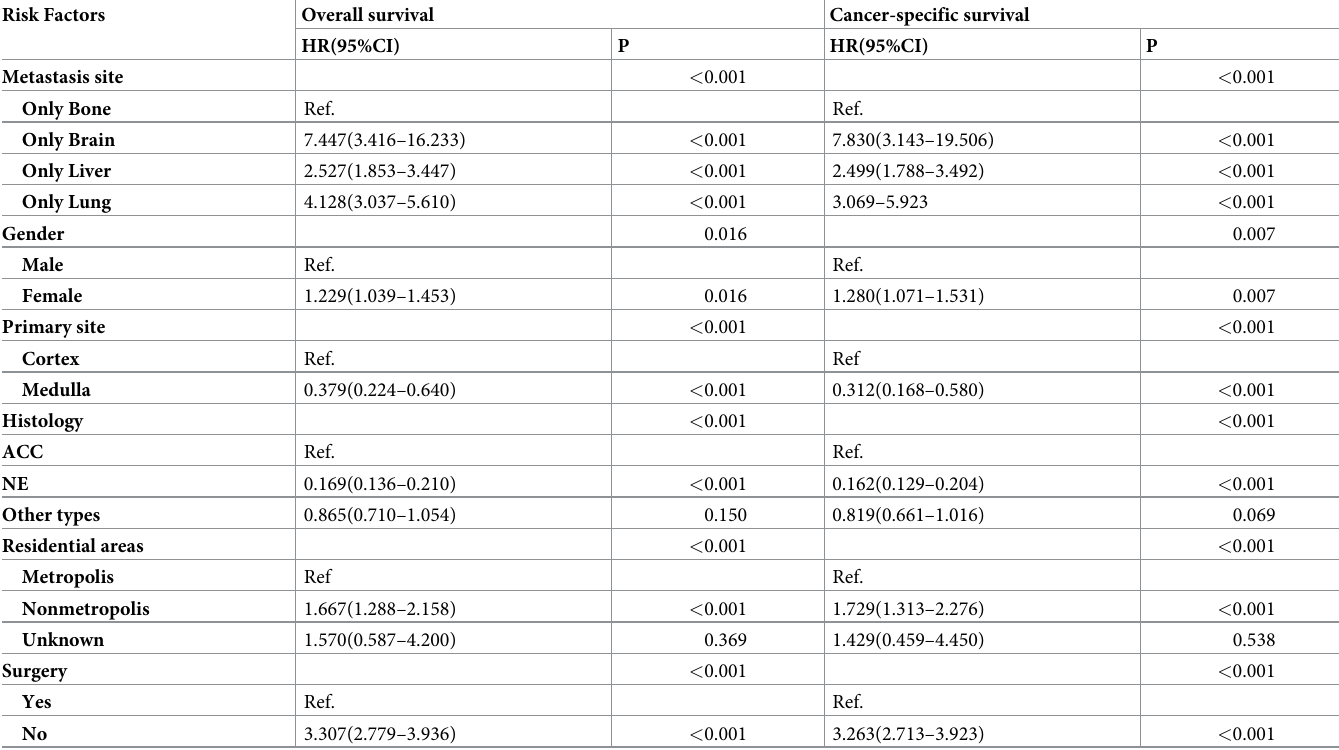
Table 4. Univariate survival analysis predicting overall survival and cancer-specific survival in patients with four single